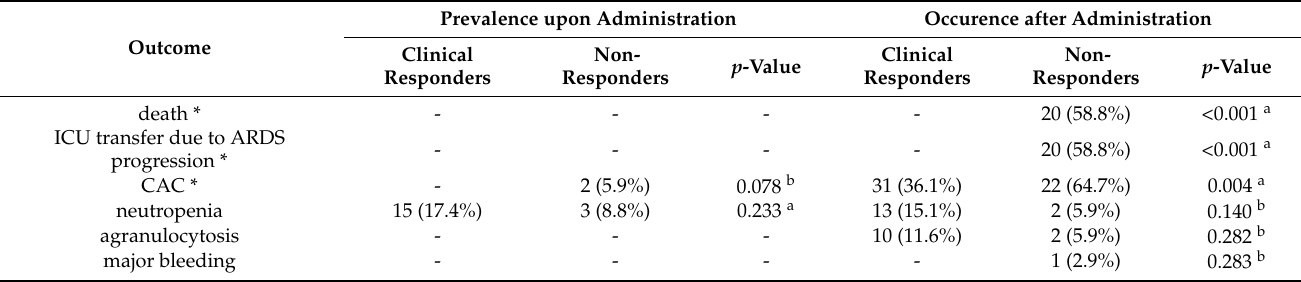
Table 6. Major outcomes and their prevalence upon administration and occurrence after treatment with tocilizumab in studied groups. Analyses have been conducted on adjusted